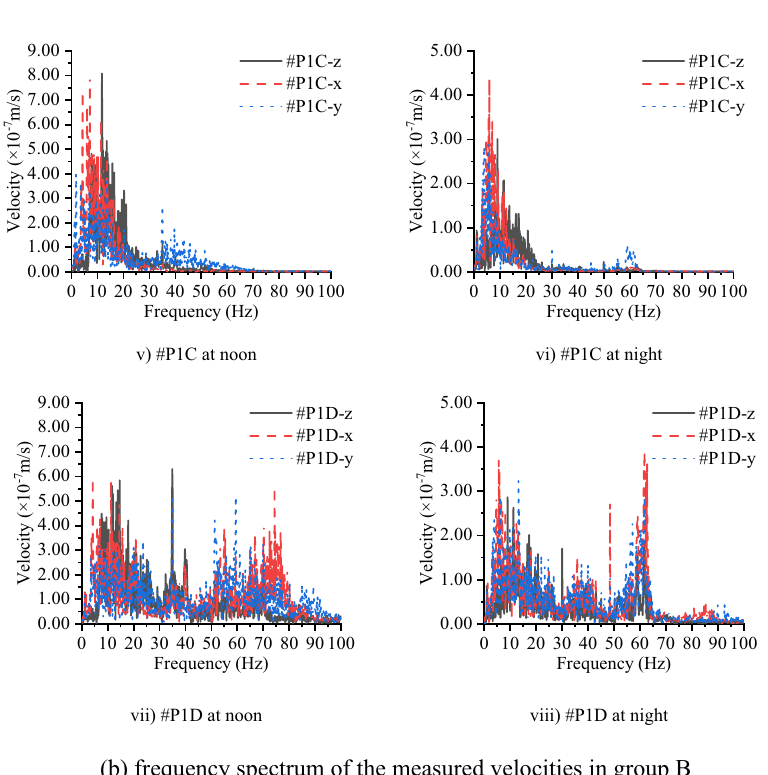
Figure 12. Frequency spectrum of the measured velocities on the concrete layer and subsoil in group A and group